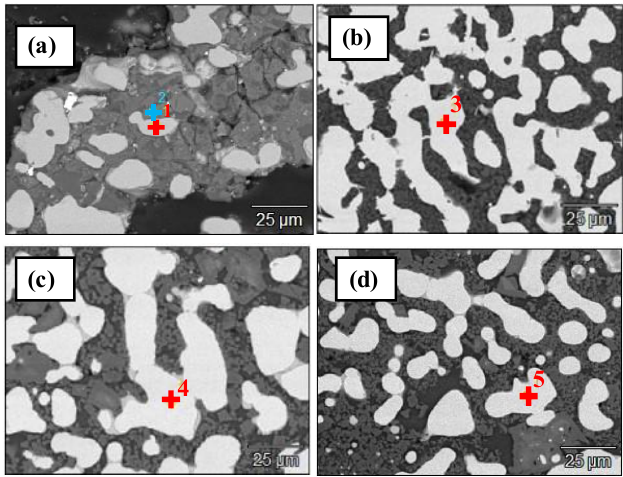
Figure 11. SEM images of ferronickel particles of reduction products at various anthracite dosage: ( a ) 12 wt%; ( b ) 16 wt%; ( c ) 20 wt%; ( d ) 24 wt%. Table 4. EDS analysis results of co-reduction product for areas in Figure 11.